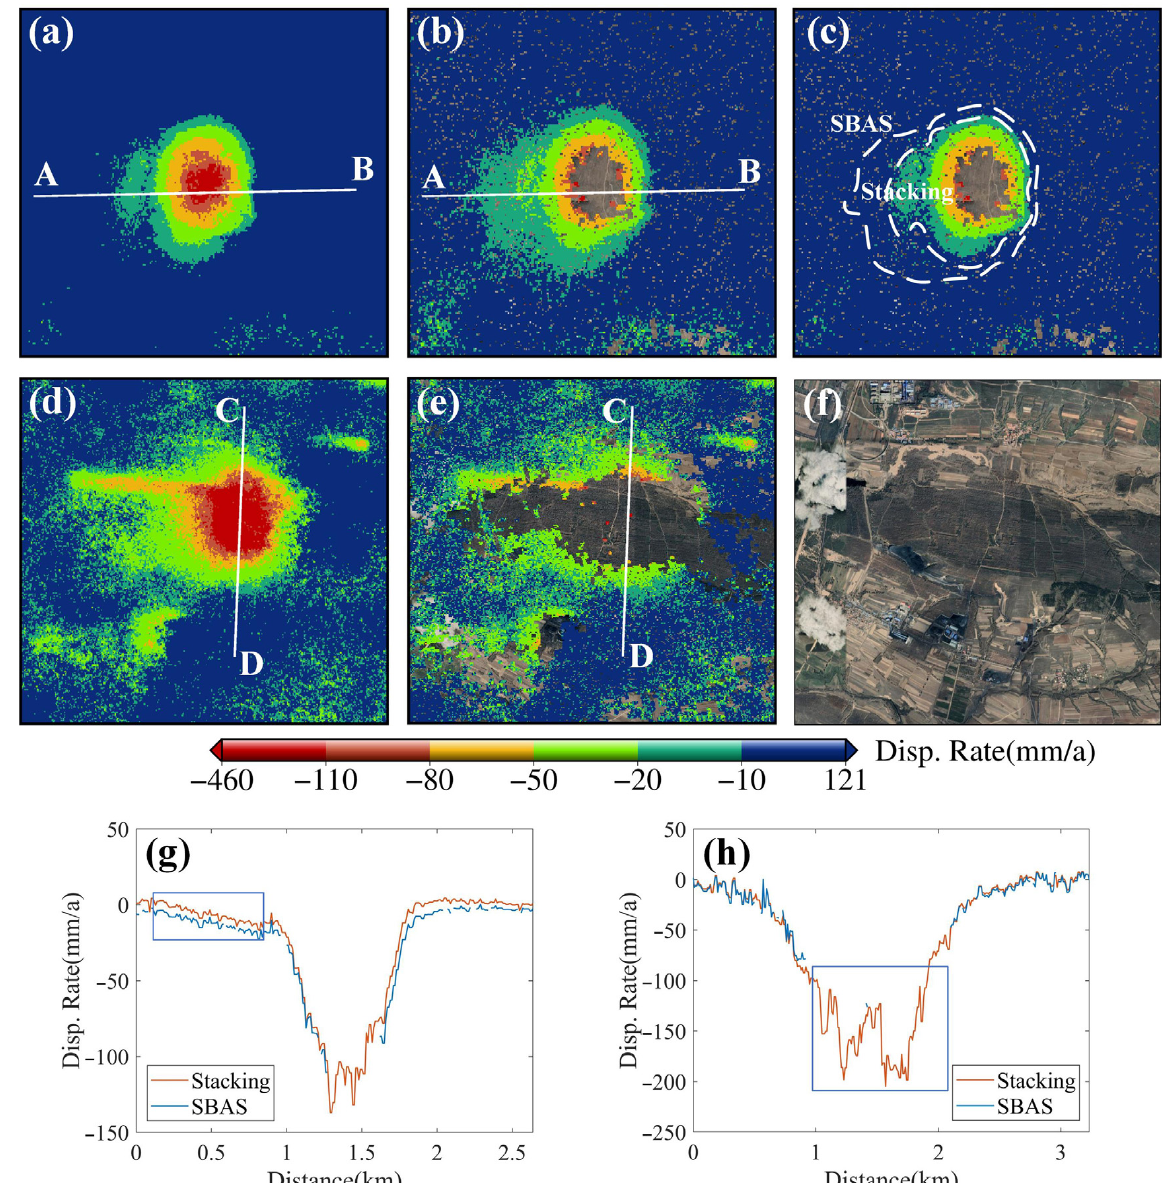
Figure 10. Stacking-InSAR and SBAS-InSAR local monitoring results: ( a ) and ( d ) are the monitoring results of stacking-InSAR; ( b ) and ( e ) are the monitoring results of SBAS-InSAR; ( g ) and ( h ) are the displacement rate line diagrams of section lines AB and CD, respectively. ( c ) The constant offset result of SBAS-InSAR, which takes the stacking-InSAR result of point A as the reference. ( f ) Is the optical remote sensing data.